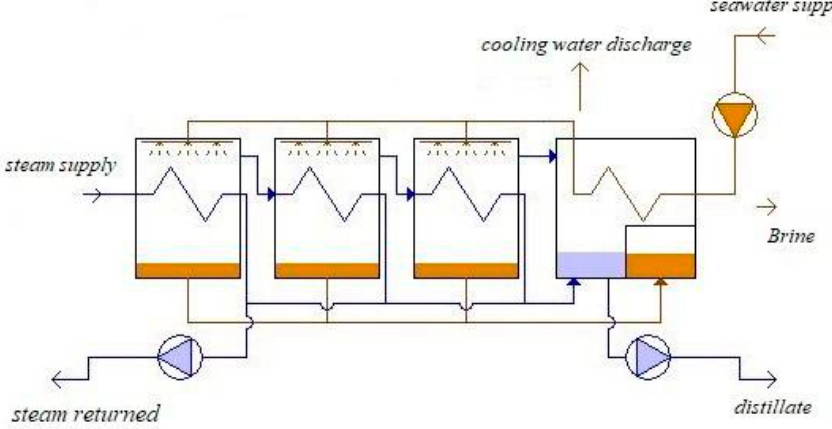
Figure 3. Schematic of the multi-effect distillation (MED) system. In the MED section, seawater first enters the desalination condenser at seawater temperature (20 ◦ C). The inlet seawater is used as the cooling water of the desalination condenser and converts the steam supply into a liquid state. After a little warming, the seawater is directed to two different system components. One part enters the MED desalination effects as feedwater, while the other one leaves the condenser unit as cooling water discharge and return to the sea (if there is no RO unit downstream). Note that the MED unit is driven by the steam from the LP section of the HRSG unit of the CCPP. The feedwater is sprayed from above onto the pipes containing hot steam and part of it evaporates in the process, due to the low pressure of the effects and high temperature. The rest of the feedwater moves as a brine with progressively higher salinity towards the exit of the desalination unit. The steam produced by the evaporation of saltwater enters the unit as a stimulus side effect. After the first MED effect, the supply steam turns into a liquid state due to heat loss, and leaves the desalination unit. This flow, referred to as “steam returned”, is then mixed with the outlet flow from the CCPP condenser to be used as feedwater of the HRSG unit. The produced distillate is extracted from the desalination condenser as a freshwater stream. In a MED plant, the cooling water discharge from the condenser has a higher temperature than seawater. However, its salinity is equal to that of seawater. To increase the amount of freshwater produced, the cooling water discharge stream can be used as feedwater for a RO desalination unit. Figure 4 shows a schematic diagram for the RO desalination unit considered in this